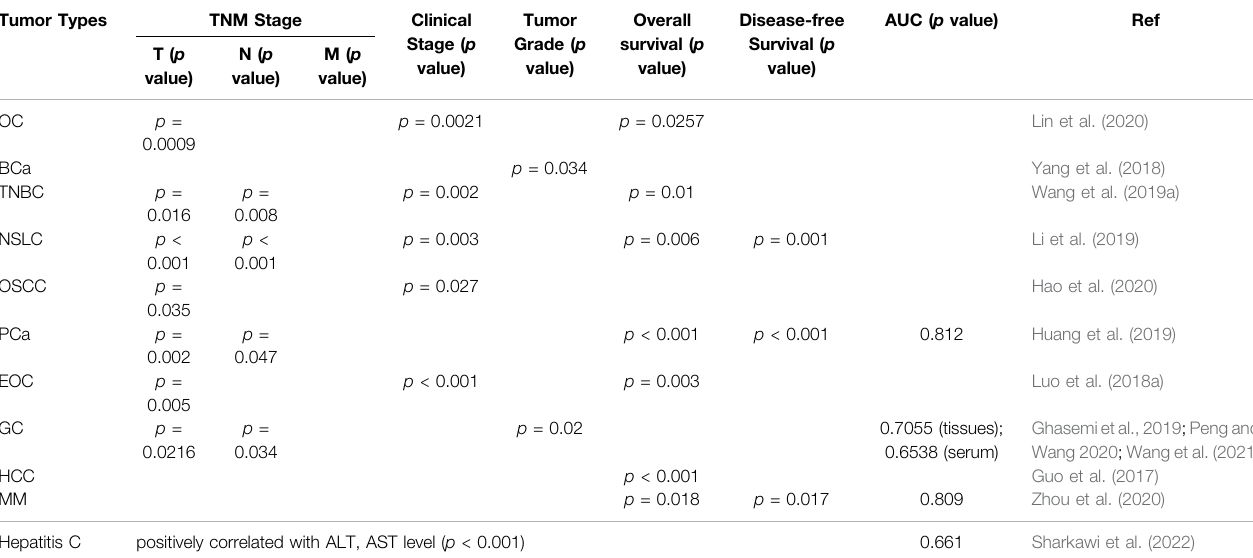
TABLE 3 | Clinicopathological features related to circ-ITCH in human diseases. Tumor